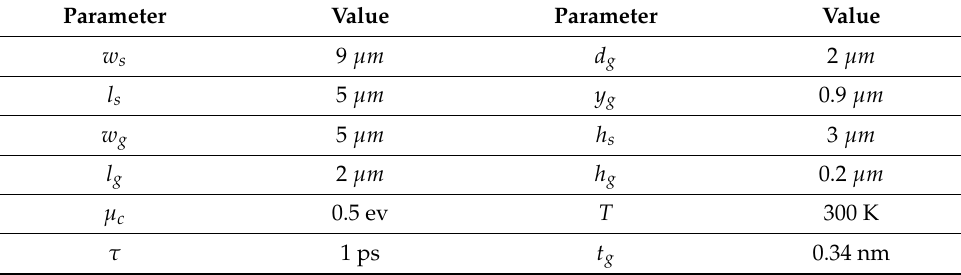
Table 1. Proposed absorber’s optimized